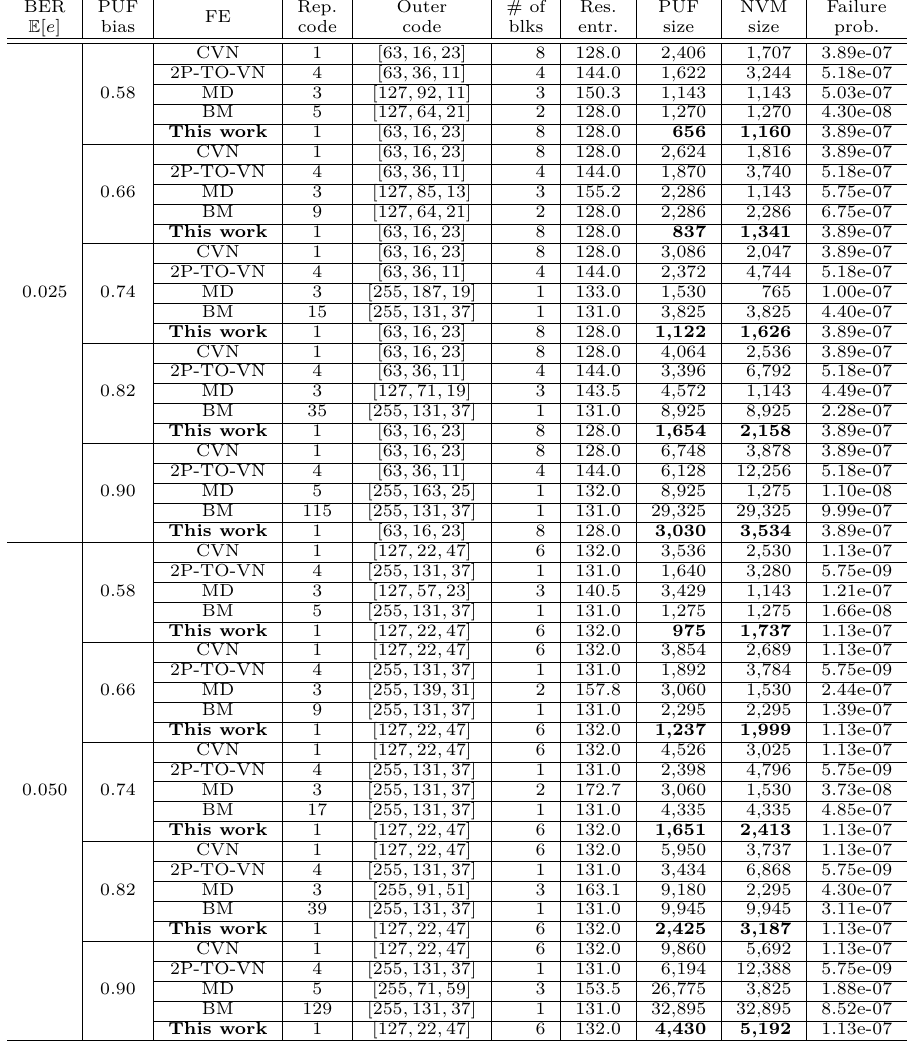
Table 4: Simulation results of 128-bit key generation using proposed and conventional binary debiasing-based FEs for averaged BER E [ e ] = 0 . 025 and 0 . 050 BER FE